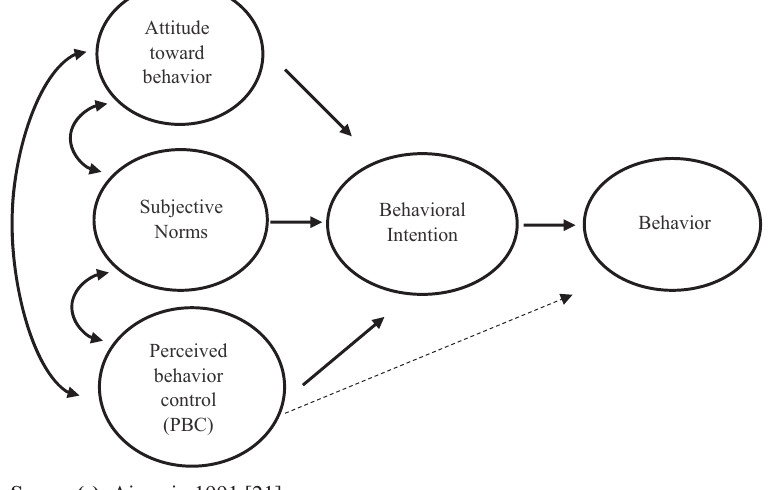
Figure 1. Theory of planned